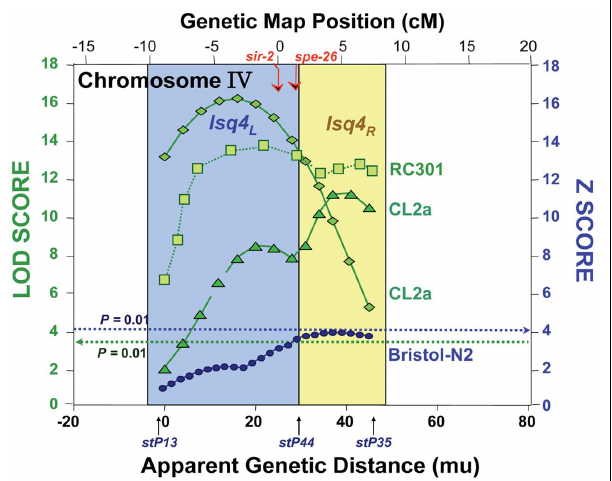
FIGURE 1 | Composite of multiple mappings for crosses between Bergerac-BO (a common reference strain with > 500 transposon markers) and other C. elegans strains. Data are drawn from references (Ebert et al., 1993; Ayyadevara et al., 2003, 2001).The Bristol-N2 × BO cross was analyzed by non-parametric interval mapping, which produces Z scores as output (right ordinate), while the others (RC301 × BO and two independent CL2a × BO crosses) were analyzed by categorical trait interval-mapping (Ayyadevara et al., 2003), for which likelihood results are generated as LOD scores (log of odds ratio; green curves refer to the left ordinate). Note that the RC301 × BO data shown here correspond to the same cross presented previously (Ayyadevara et al., 2001), but reanalyzed by our categorical trait interval-mapping procedure (Ayyadevara et al., 2003). Dashed horizontal lines indicate empirical P = 0.01 false-positive thresholds based on 1000 interval-mappings, permuting genotype with respect to LS.